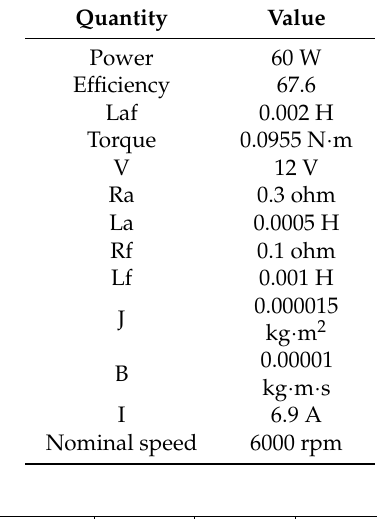
Figure 4. Electric starter, circuit, and the bond graph model [14]. Table 4. Characteristics of a DC starter motor. Table 4. Characteristics of a DC starter motor.